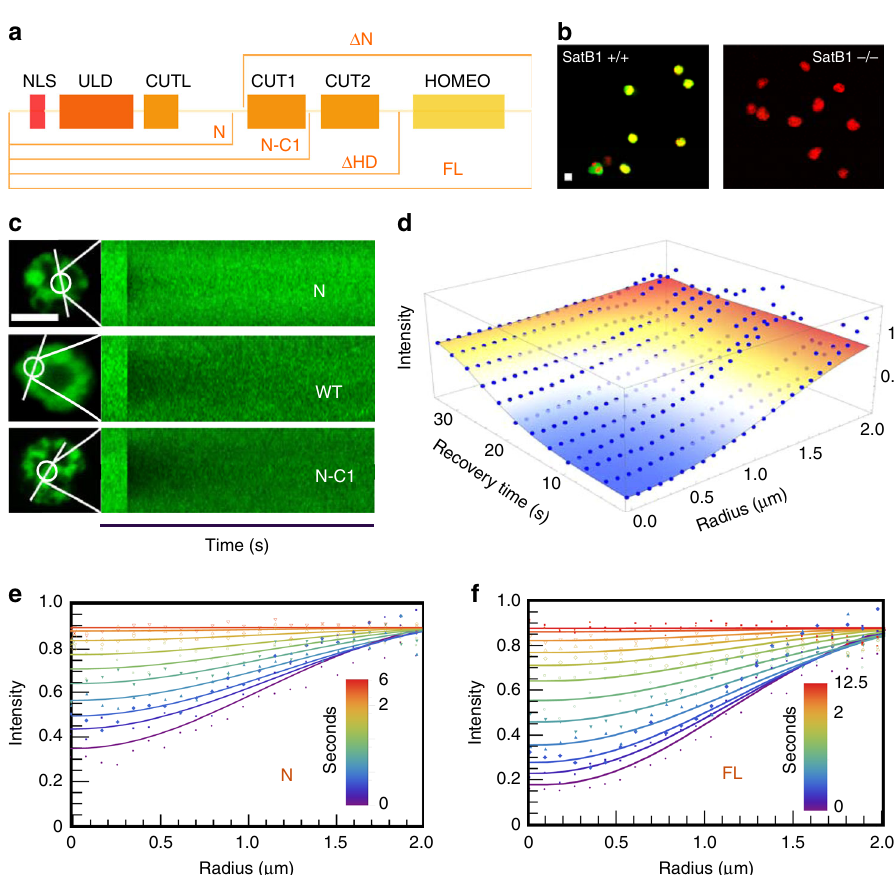
Fig. 6 Spatiotemporal FRAP analysis of Satb1 dynamics in the nucleus. a A schematic representation of the domain organization of Satb1 and the various domain constructs which were generated to study Satb1 dynamics. b Satb1 knockout lines were generated by CRISPR/Cas9 strategy. Immuno fl uorescence image of WT Vl3 3M2 cells and Vl3 3M2 cells where the native Satb1 has been knocked out (Satb1 green and DNA in red) c Examples of time versus fl uorescence intensity carpets of high resolution spatiotemporal maps of fl uorescence bleaching and recovery along scan lines bisecting a bleach spot in Satb1 − / − cells expressing exogenous eGFP fusions of FL Satb1 and different domain constructs. d The best- fi t surface to a FL Satb1 spatiotemporal FRAP data. e , f The best fi ts of representative recovery pro fi les for N ( e ) and FL ( f ) are displayed at select times, with the color bar representing time in seconds. For estimates of spatiotemporal FRAP fi t parameters, as well as total number of cells analyzed per condition, see tables 1 and 2. Scale bar is 5 µ m. See source data for analysis and Supplementary Code 1 for custom analysis codes